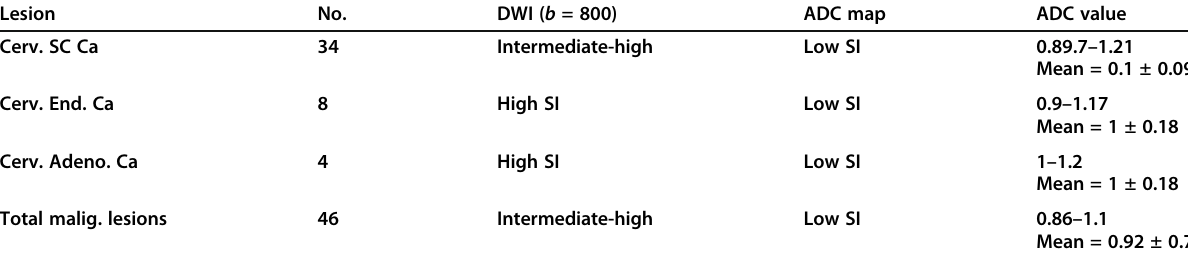
Table 3 DW-MRI and ADC values results of the 46 malignant lesions (group I) Lesion No.